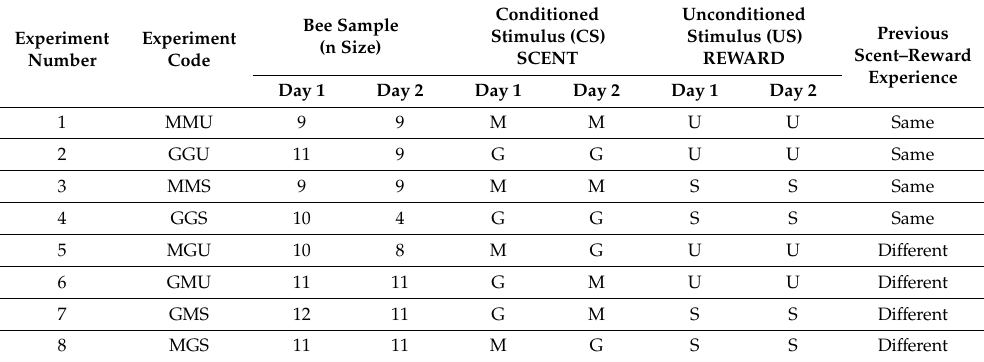
Table 1. Experiments of classical absolute conditioning conducted on two consecutive days to assess the e ff ect of scented-US reward and previous olfactory experience on olfactory learning in the stingless bee Melipona eburnea . The conditioned stimuli (CS) were mango (M) and guava (G); the unconditioned stimuli (US) were unscented-US (U) and scented-US (S). Experience with previous scent–reward associations were recorded as: same (when a single odor was used each day) and di ff erent (when two scents were used, a di ff erent one each day). Experiment code letters refer to scent used day 1, scent used day 2, and type of reward: mango mango unscented (MMU), guava guava unscented